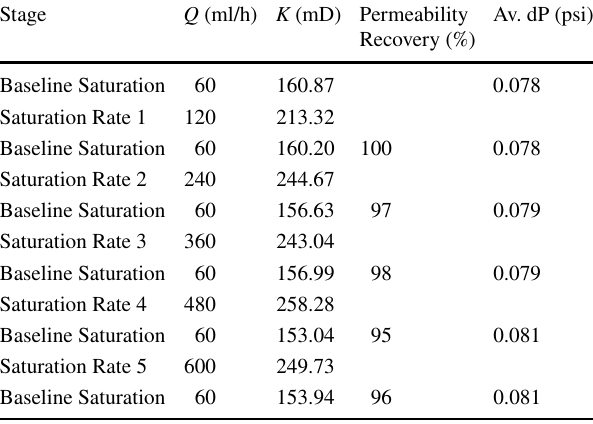
Table 9 Permeability measurements for core flood 3, temperature held constant at 136